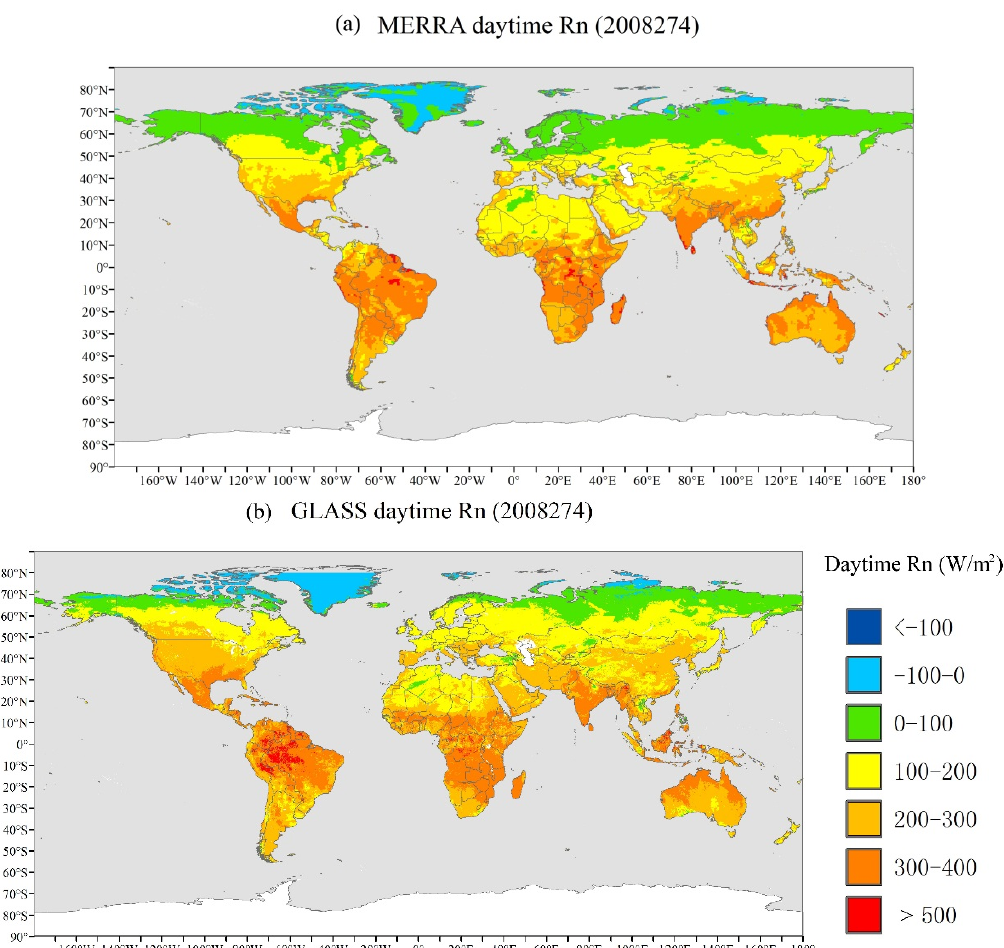
Figure 4. The MERRA ( a ) and GLASS ( b ) daytime R n products in day 274 (30 September) of 2008. The white spaces indicate the missing data.